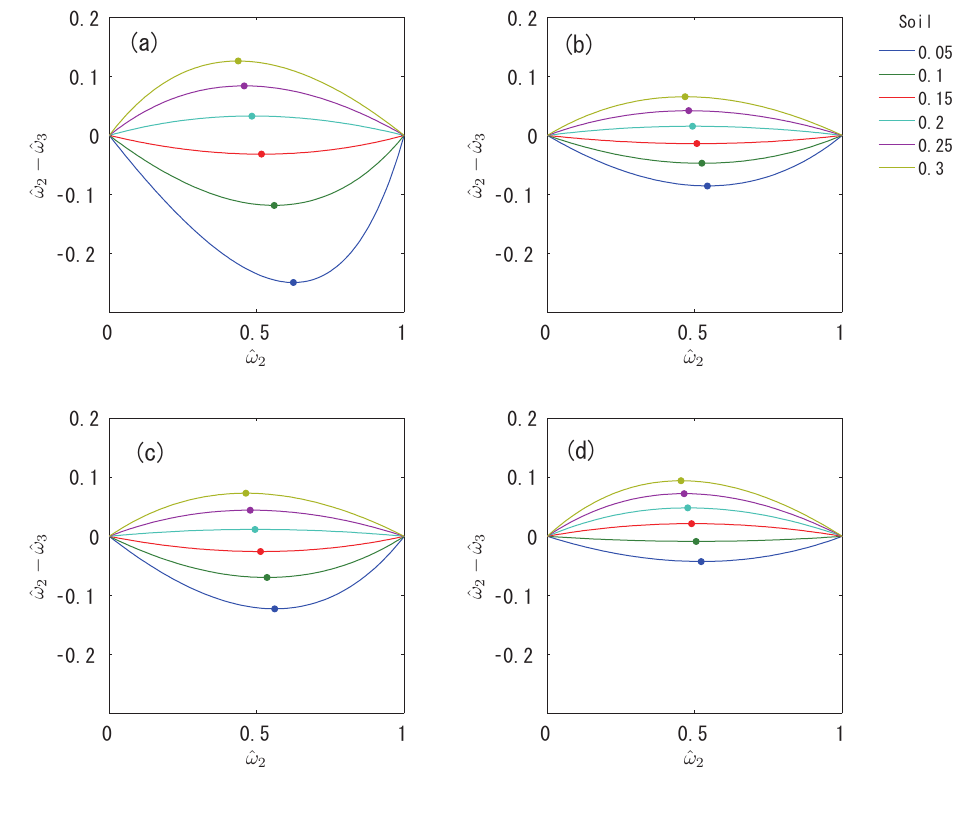
− ^ ω Figure 5 . Plot of ( ^ ω ) against ^ ω under various non-vegetation endmember spectra 3 2 2 for the case of four VIs ((a) NDVI, (b) SAVI, (c) TSAVI, and (d) EVI2). The endmember = (0 . 02 , 0 . 40) corresponding to the value of spectrum of vegetation class is fixed at ρρρ v LAI = 4 . The maximum difference for each case is indicated by a dot (computed from Equations (46) and